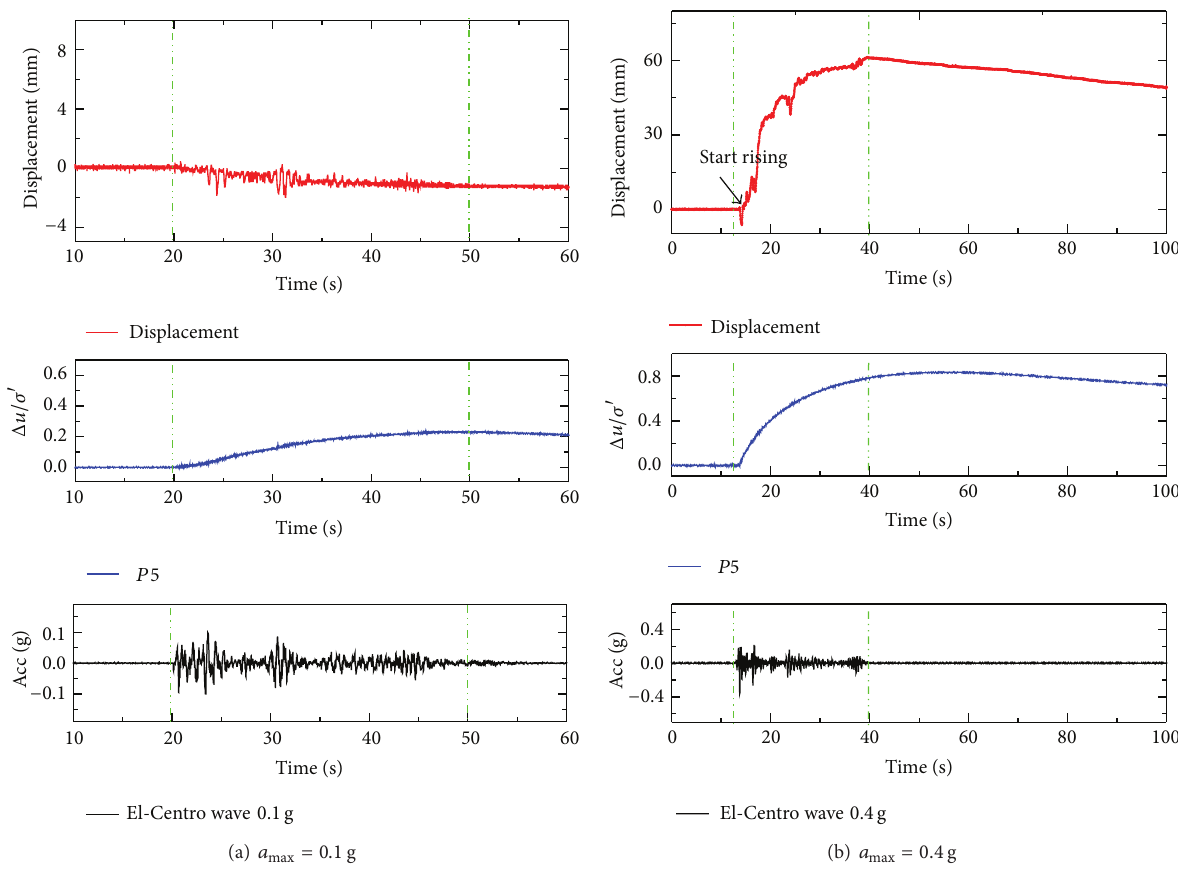
Figure 8: Uplift displacement of pipe 1# in test 2 under El-Centro